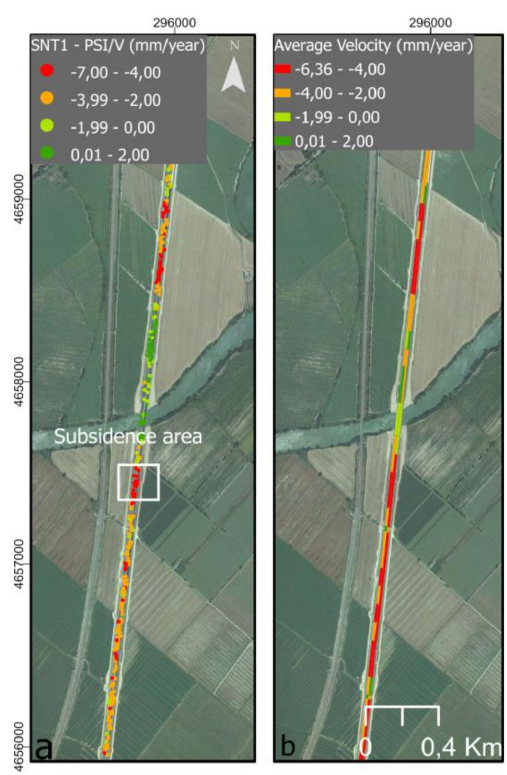
Figure 5. ( a ) Displacement map PSI Sentinel-1 for D18 highway, ( b ) Map classification section average velocity (mm / year), as background orthophoto Rome.